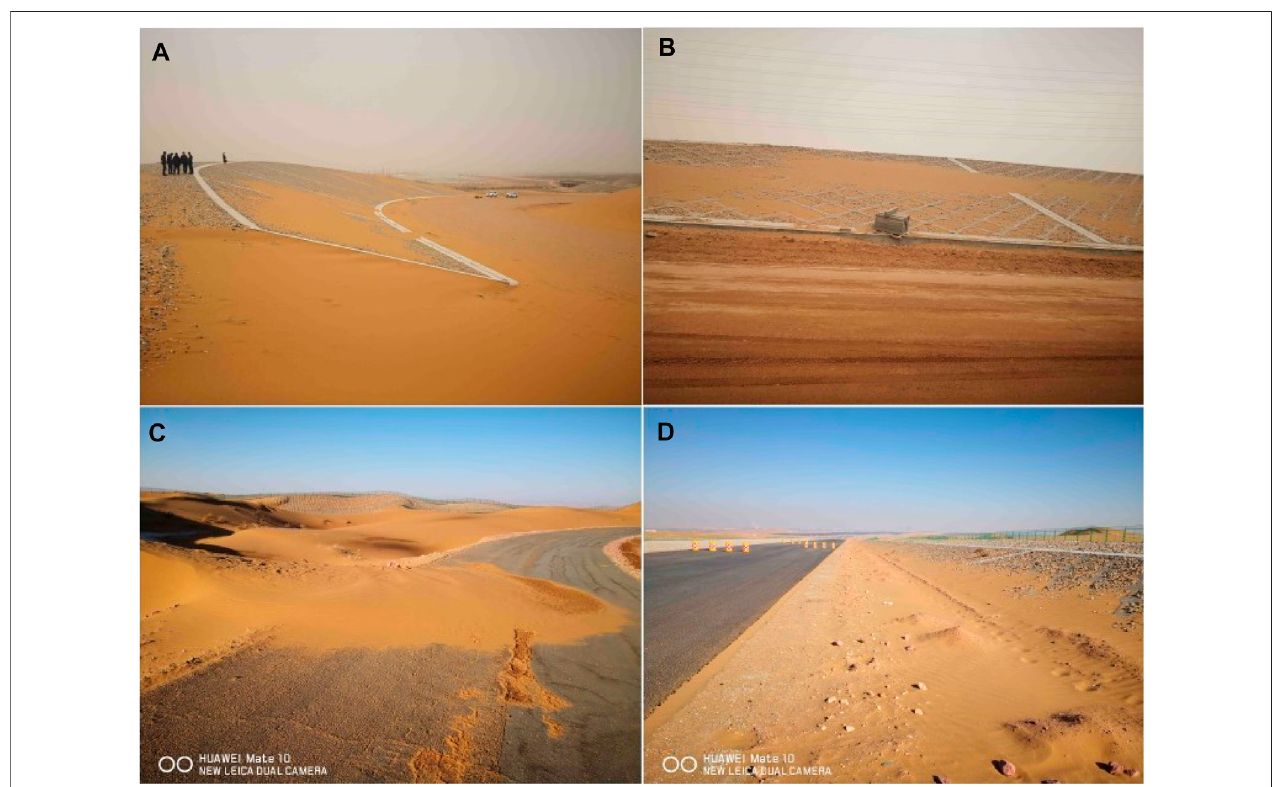
FIGURE 1 | The sand hazards on the Tengger Desert section of the Wuhai-Maqin Highway. (A) and (B) highway roadside; (C) and (D) highway subgrade.